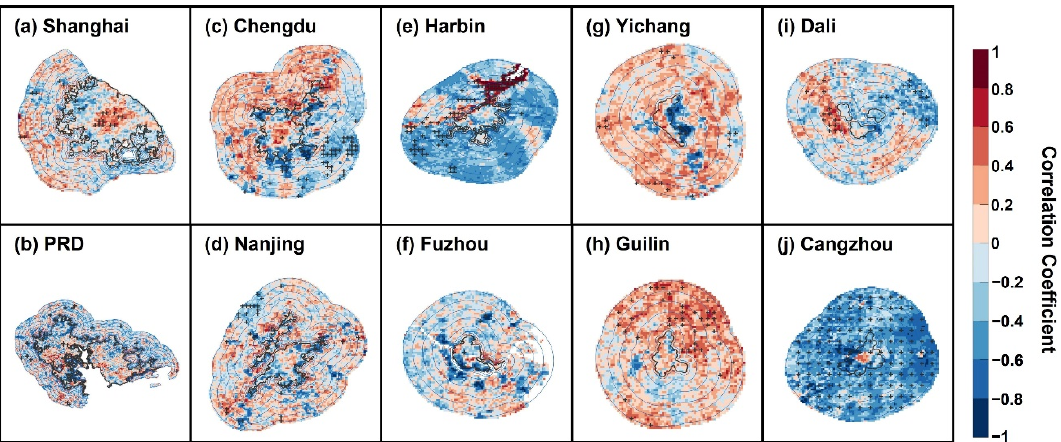
Figure 8. Spatial pattern of correlation coefficient between NDVI and LST across ten cities from 2000–2020. The cross-shaped portion illustrate the trends statistically significant at the 5% levels. The black lines represent city boundaries.